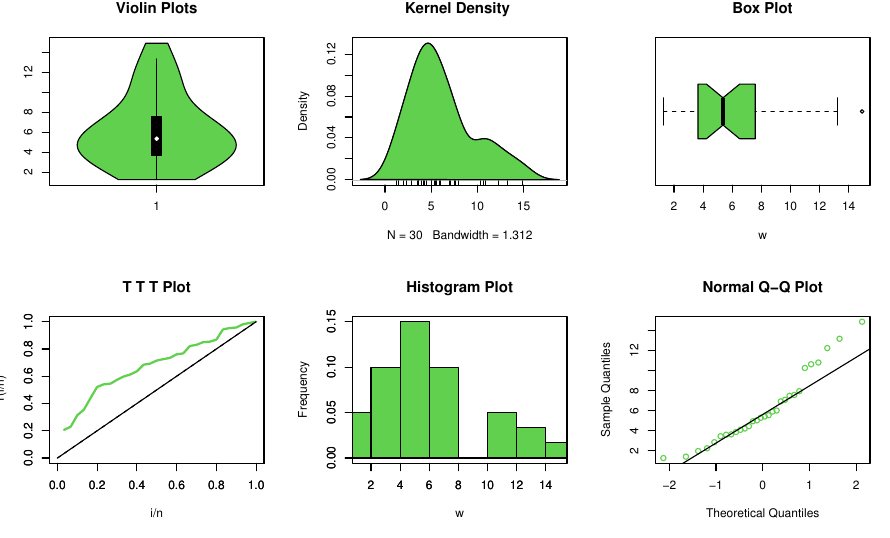
Figure 4. Non-parametric plots for data set